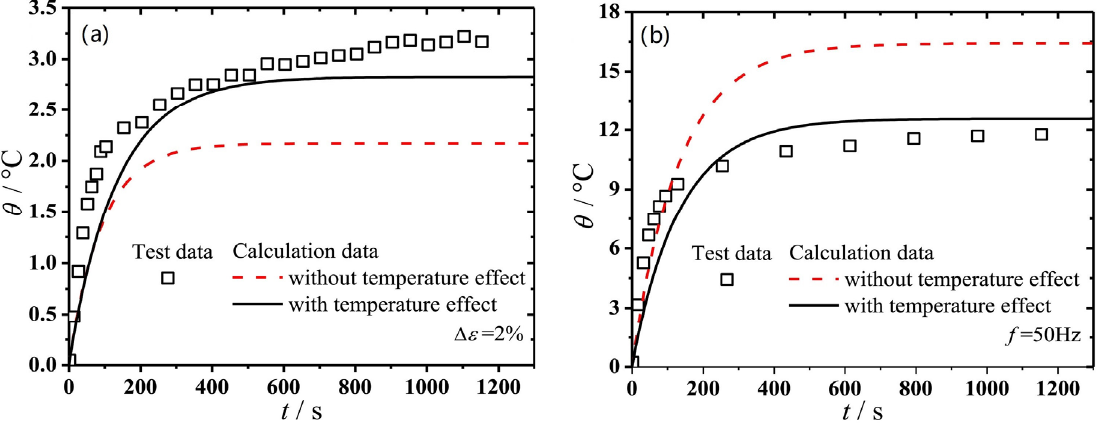
Figure 10. Comparison of the temperature rise results between simulation and test. ( a ) Frequency is 50 Hz and pre-strain 20%. ( b ) Strain amplitude is 5% and pre-strain 20% [75]. The heat generation and the hysteresis loss of rubber composites under different fre- The amplitude of the Payne effect is tended to rise with the temperature dropping.